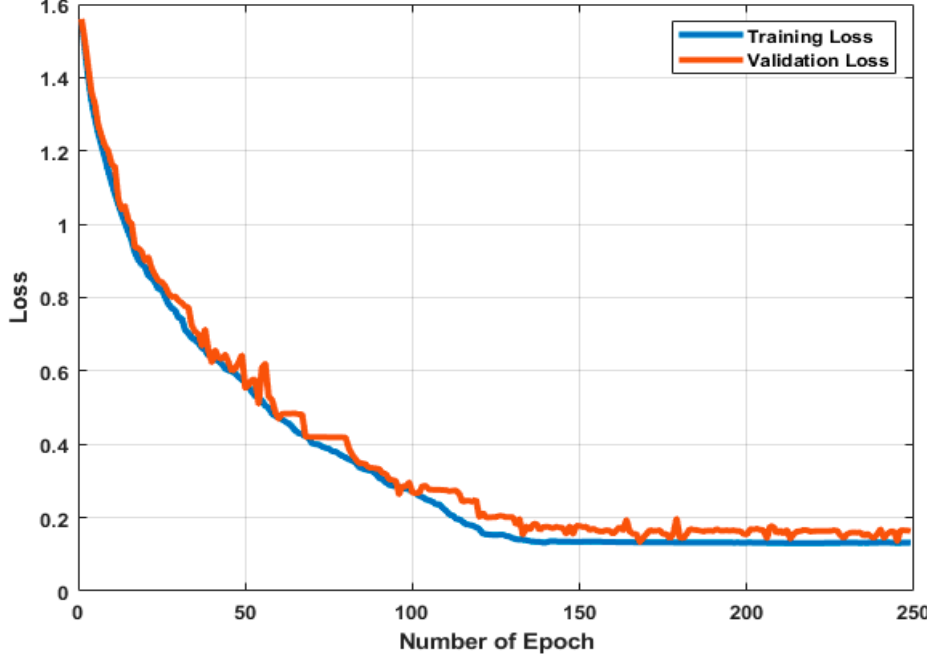
Figure 22. The results for the training and validation data (Loss Function).